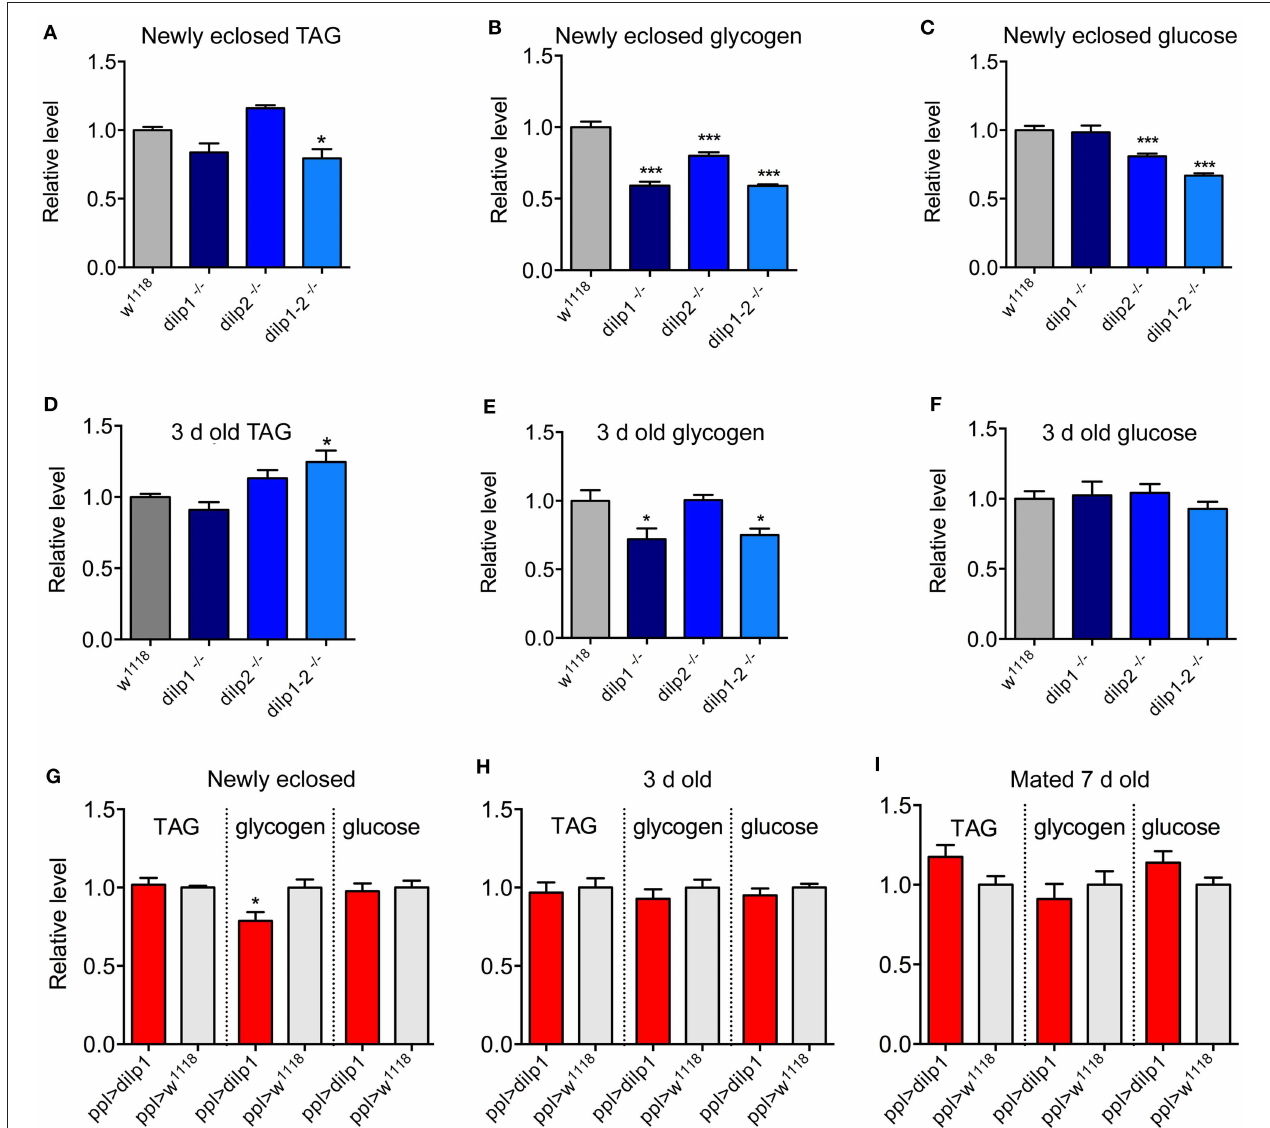
FIGURE 4 | Contents of TAG, glycogen, and glucose in female mutant flies and after ectopic dilp1 expression. (A–C) Contents of TAG and carbohydrates in recently emerged mutants and controls. Note that for dilp1 mutants, only glycogen was diminished, whereas for dilp1-2 mutants, all three compounds were decreased. Eight replicates per genotype with 5–6 flies in each replicate (* p < 0.05, *** p < 0.001, one-way ANOVA followed by Tukey’s test). (D–F) In 3-day-old flies, glycogen was also reduced in dilp1 mutants and double mutants. Eight replicates per genotype with 5–6 flies in each replicate (* p < 0.05, *** p < 0.001, one-way ANOVA followed